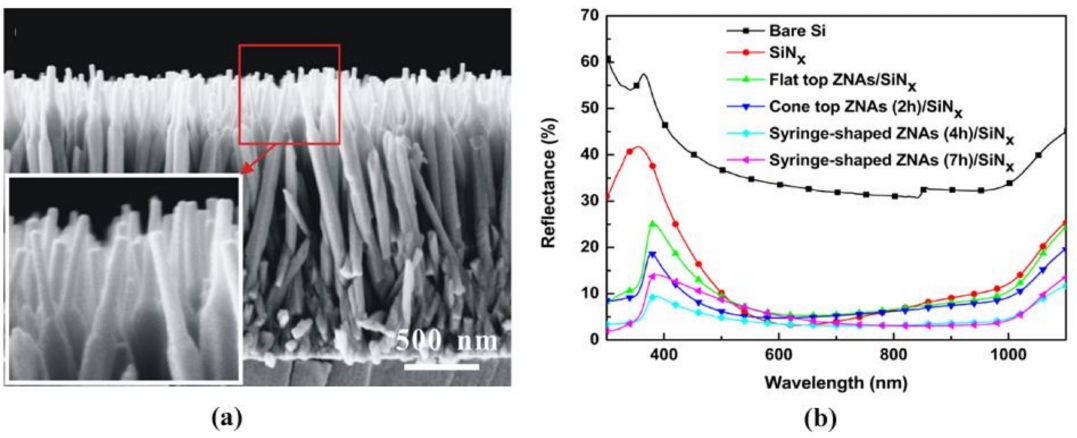
Figure 20. ( a ) Cross-section SEM image of the syringe-shaped ZnO nanorod arrays. ( b ) Comparison of reflectance of mc-Si PV cells with various surface conditions. Reprinted with permission [172]; 2018,